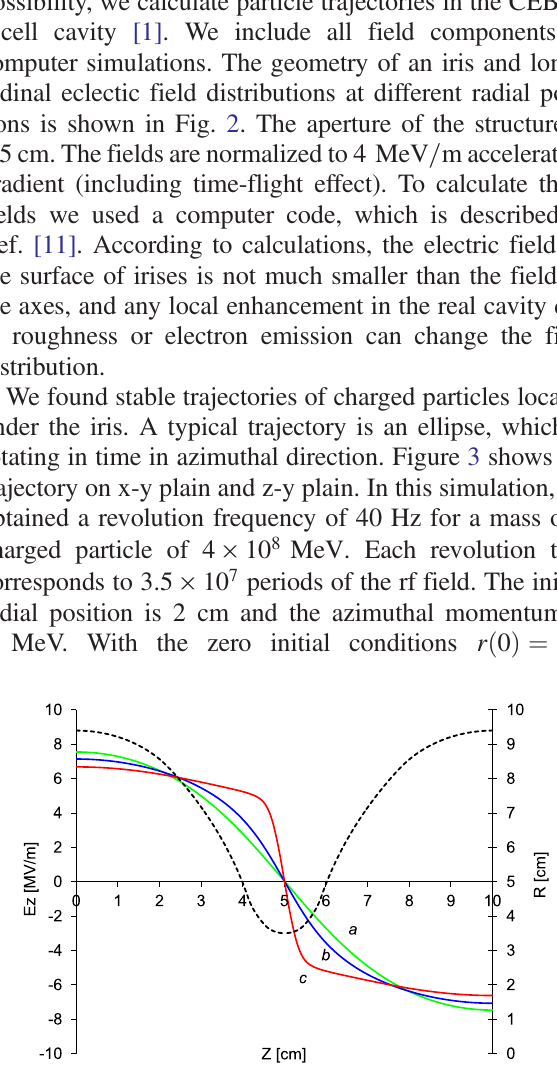
FIG. 2. Geometry of an iris of a CEBAF multicell cavity (gray line). Longitudinal electric field at a different radial position: r ¼ 0 cm (green line), r ¼ 2 . 5 cm (blue line), r ¼ 3 . 45 cm (red line). Fields are normalized to 4 MeV = m accelerating